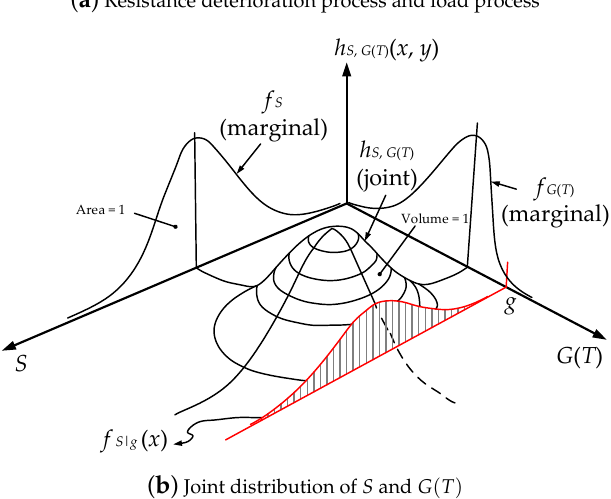
Figure 1. Illustration of the processes of load and resistance